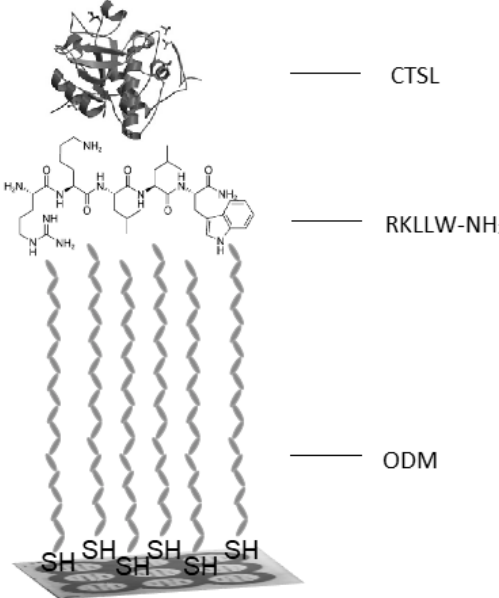
Figure 6. The schematic illustration of the biosensor for the quantitative measurements of the CTSL. ODM—1-octadecanothiol, RKLLW-NH 2 —CTSL inhibitor, CTSL—cathepsin